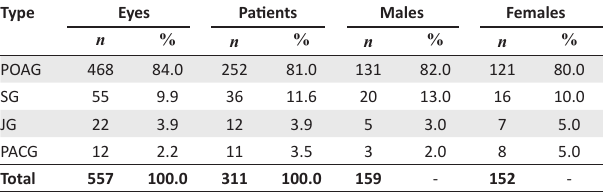
TABLE 1: Distribution of the types of glaucoma for 311 patients, classified also by gender.